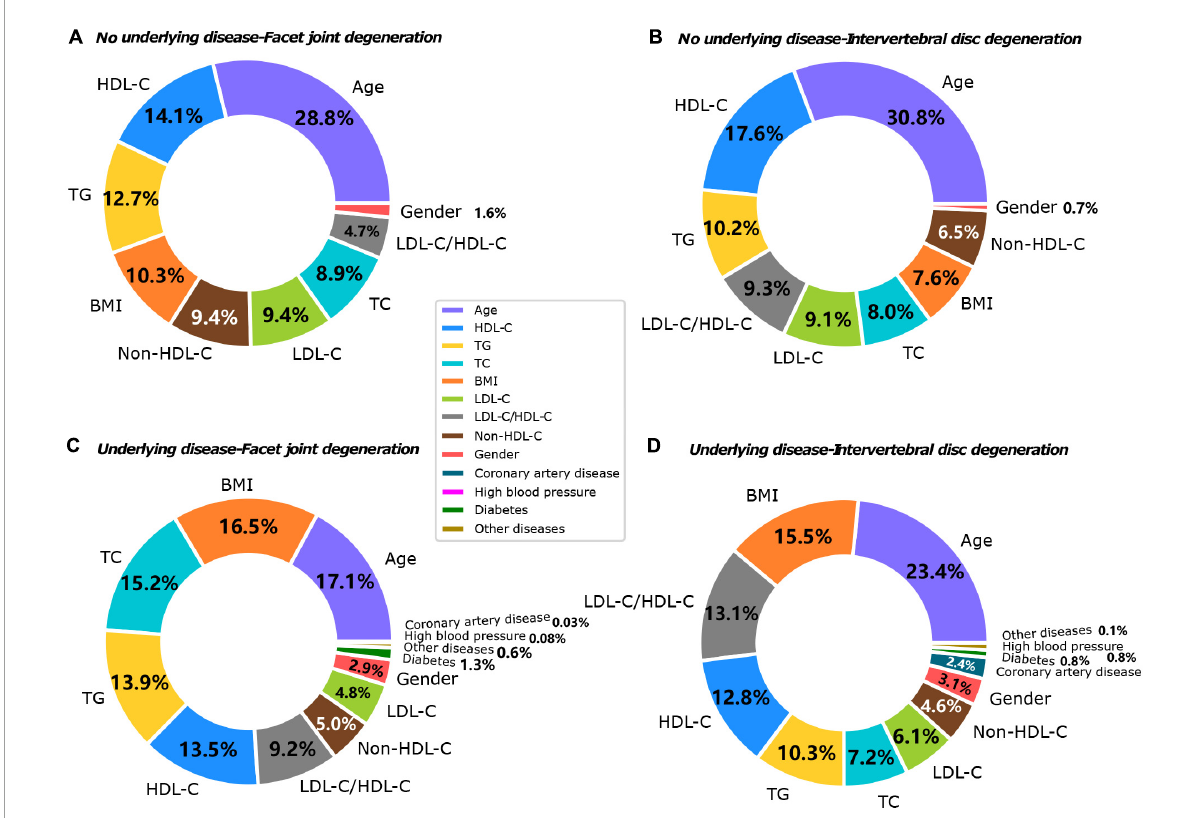
FIGURE3 Contributing factors to IVDD in both groups. (A) No underlying disease-facet joint degeneration. (B) No underlying disease-IVDD. (C) Underlying disease-facet joint degeneration. (D) Underlying